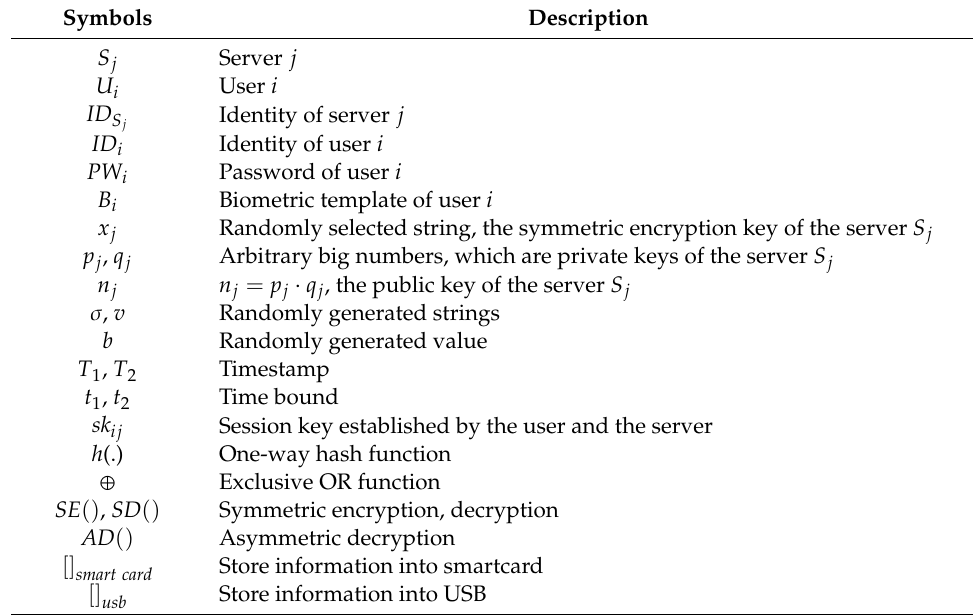
Table 1. Notations used in the proposed